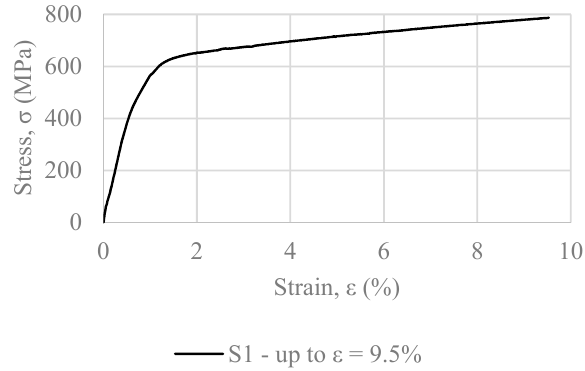
Figure 8. Stress vs. strain curve up to 9.5%, specimen S1.